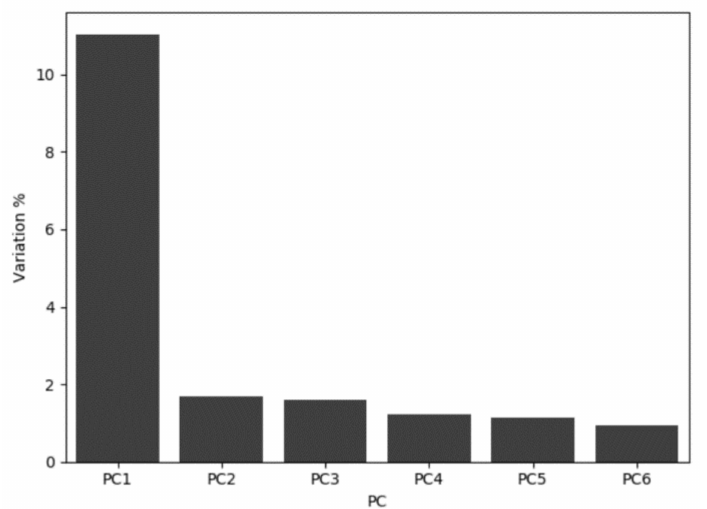
Figure 6. The amount of variation captured by the first six components using a PCA